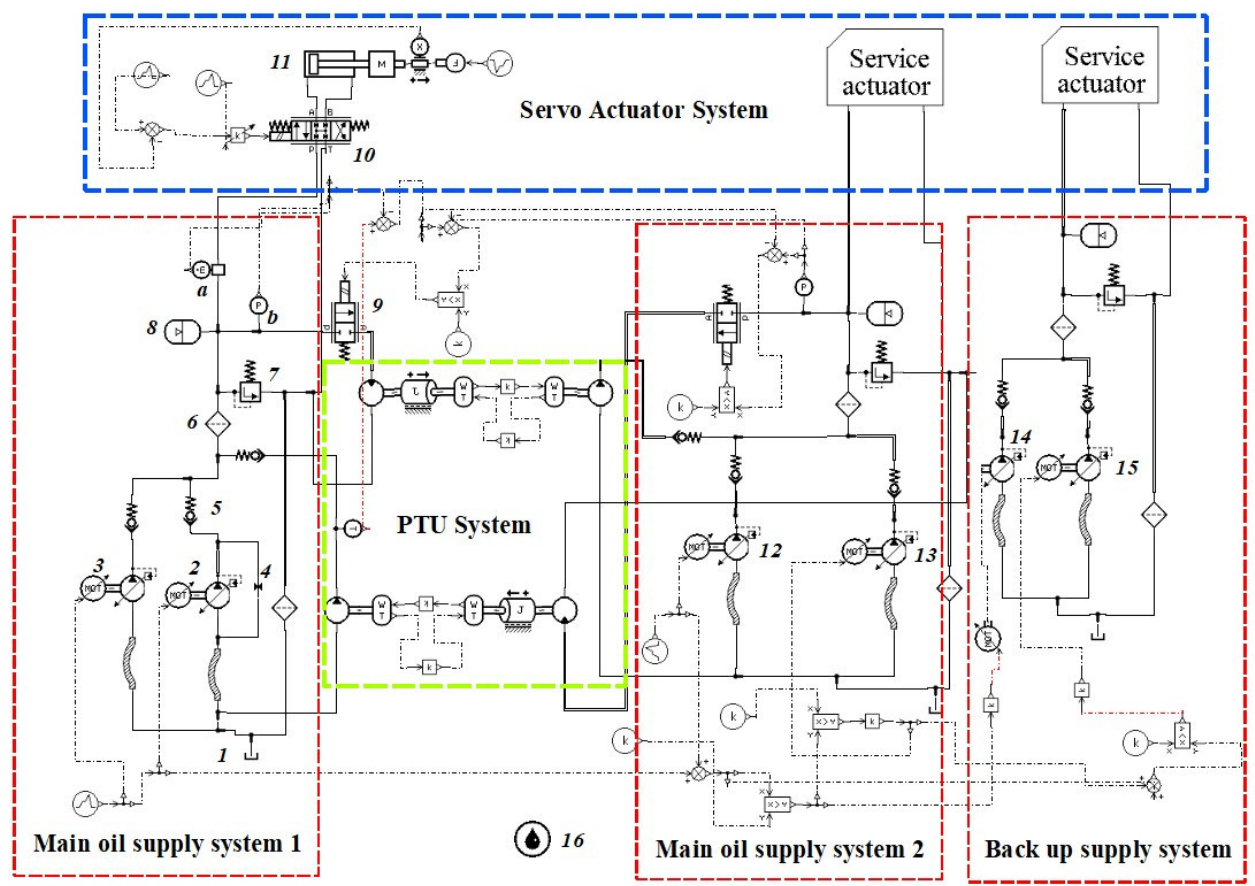
Figure 2. An aircraft hydraulic system built by AMESIM.